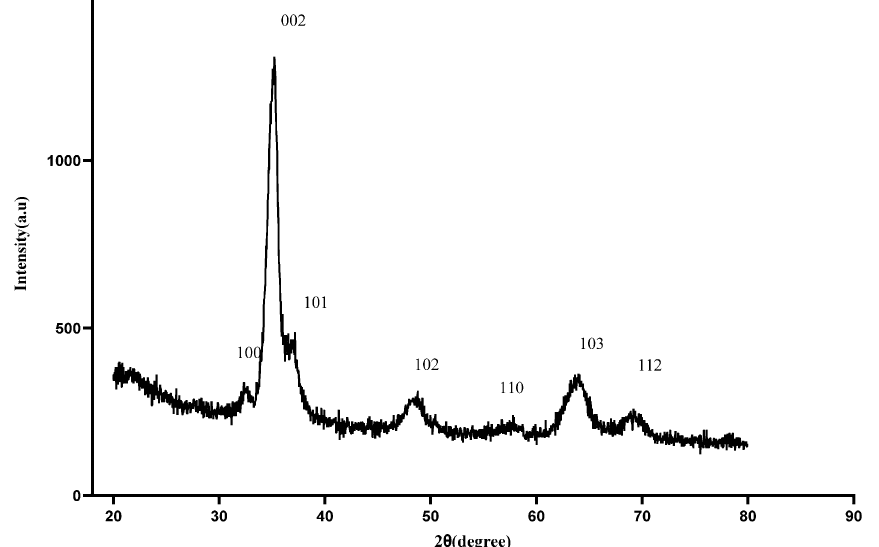
Figure 2. XRD Pattern of flexible UV PDs based on ZnO on the fiberglass (FR4) substrate.